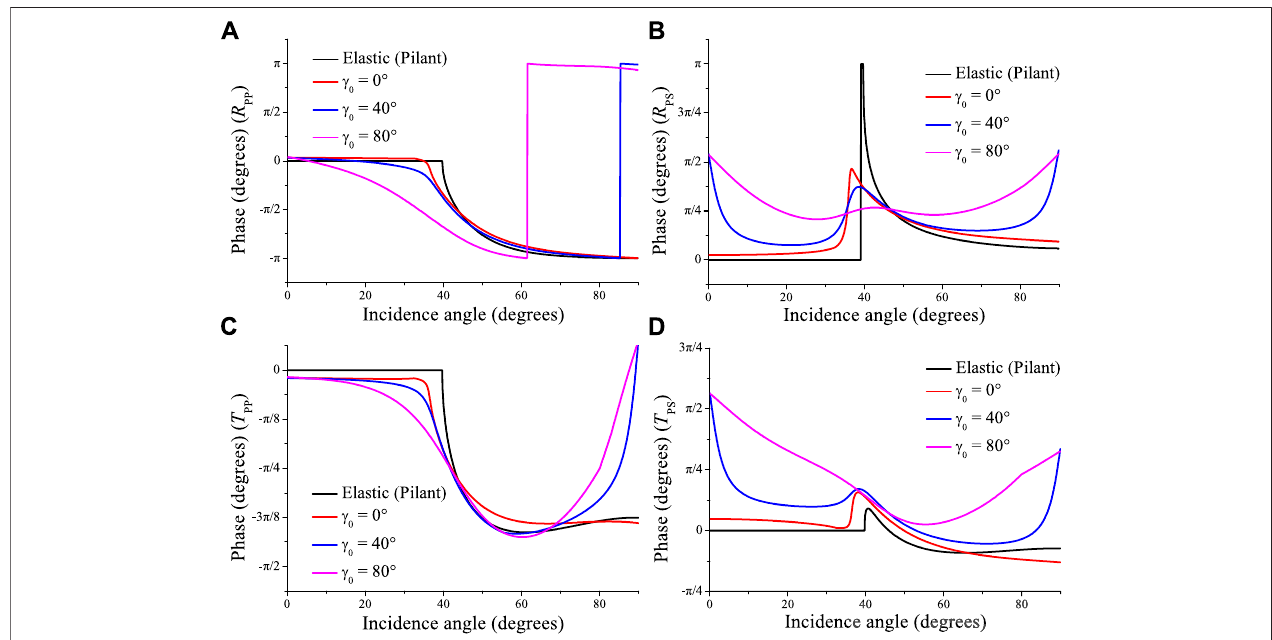
FIGURE 5 | Same as Figure 4 but for the phase angles of the re fl ected P (A) , re fl ected S (B) , transmitted P (C) and transmitted S (D) waves.